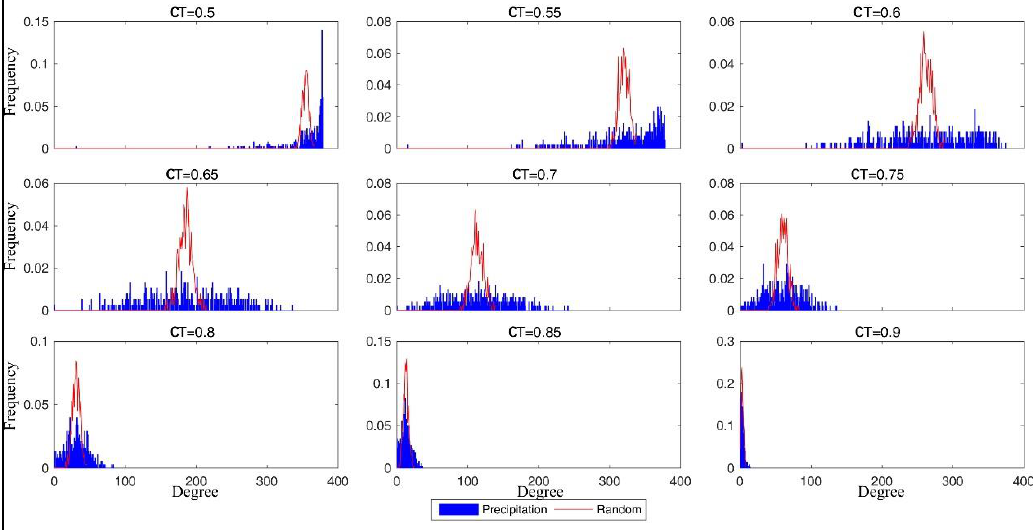
Figure 8. Degree distribution of the P-network and random networks.